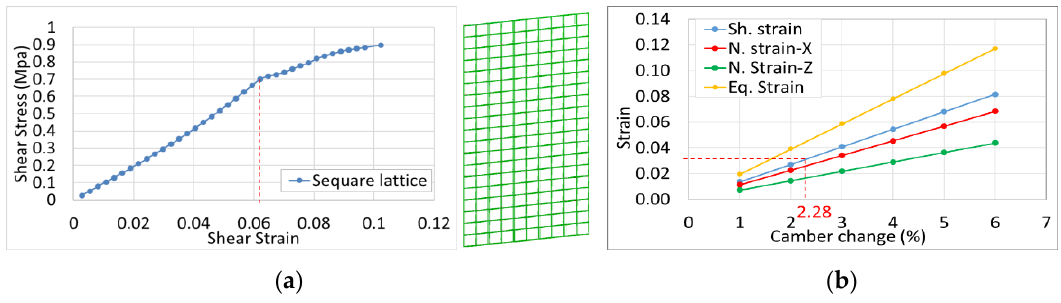
Figure 15. ( a ) In-plane shear stress/strain curve and ( b ) percentage of camber change vs. corresponding strain.